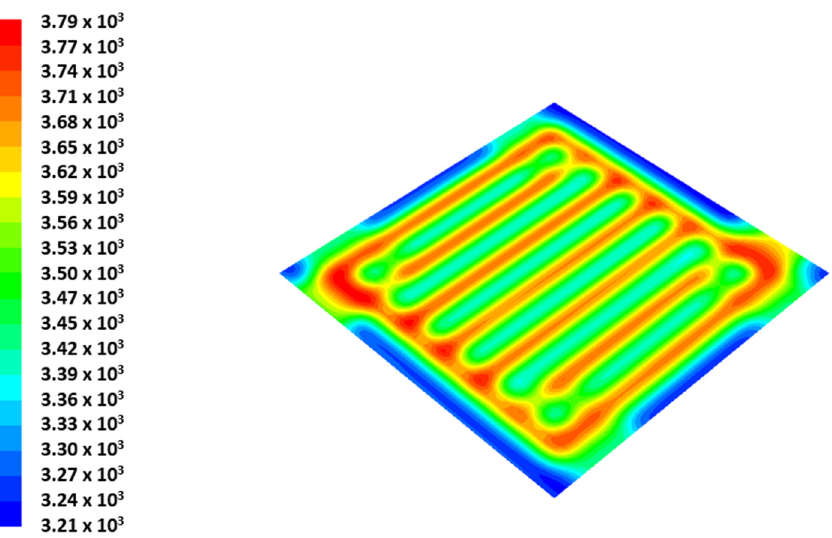
Figure 8. Current density (A/m 2 ) distribution contour of small-scale 7-channel Model.